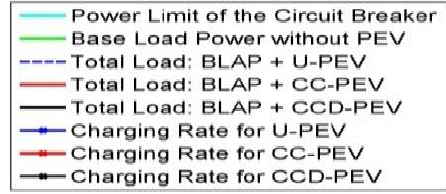
Figure 5. Power profiles and charging rate profiles at home.